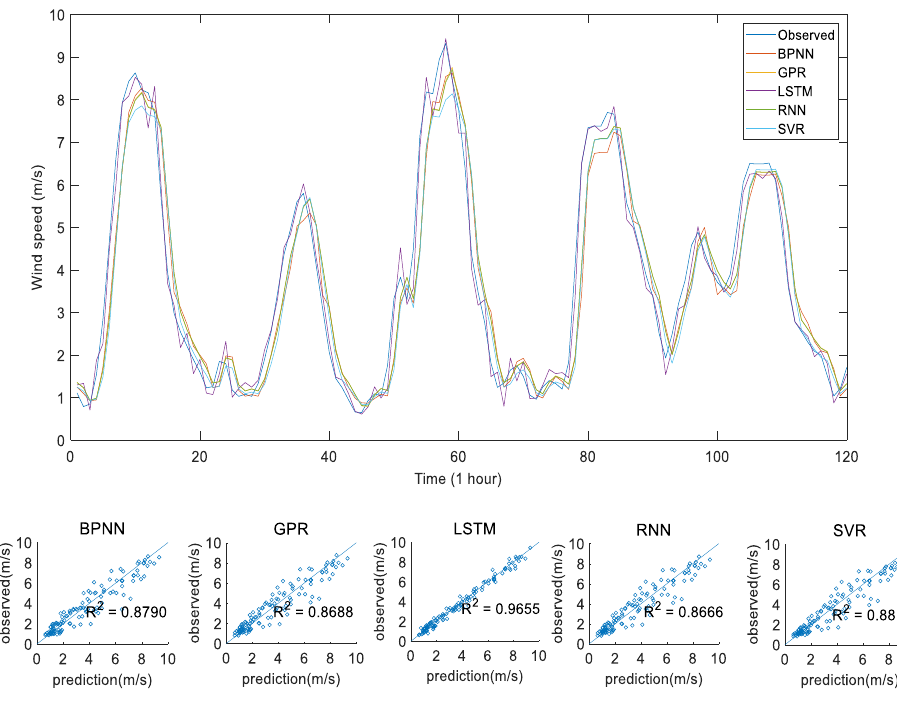
Figure 5. Forecast results in Case I.